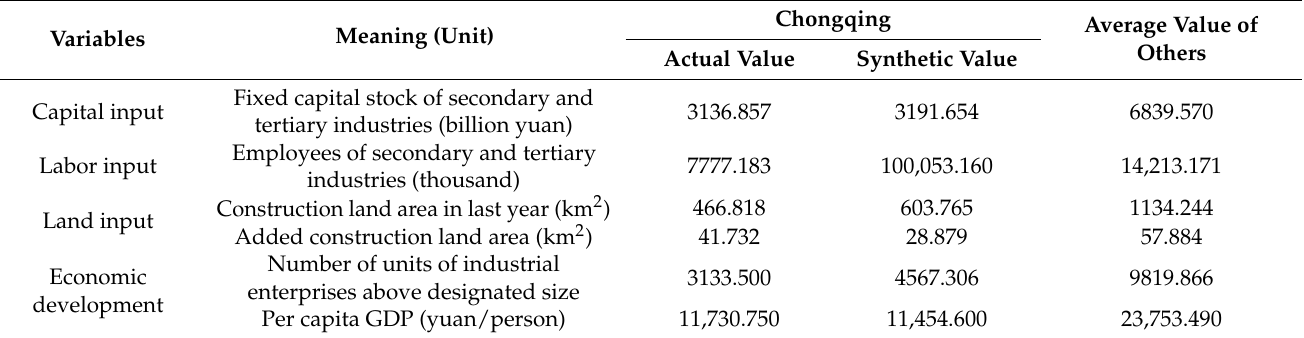
Table 2. Comparison of predictor variables: actual and synthetic values of Chongqing, and average values of other provinces (autonomous